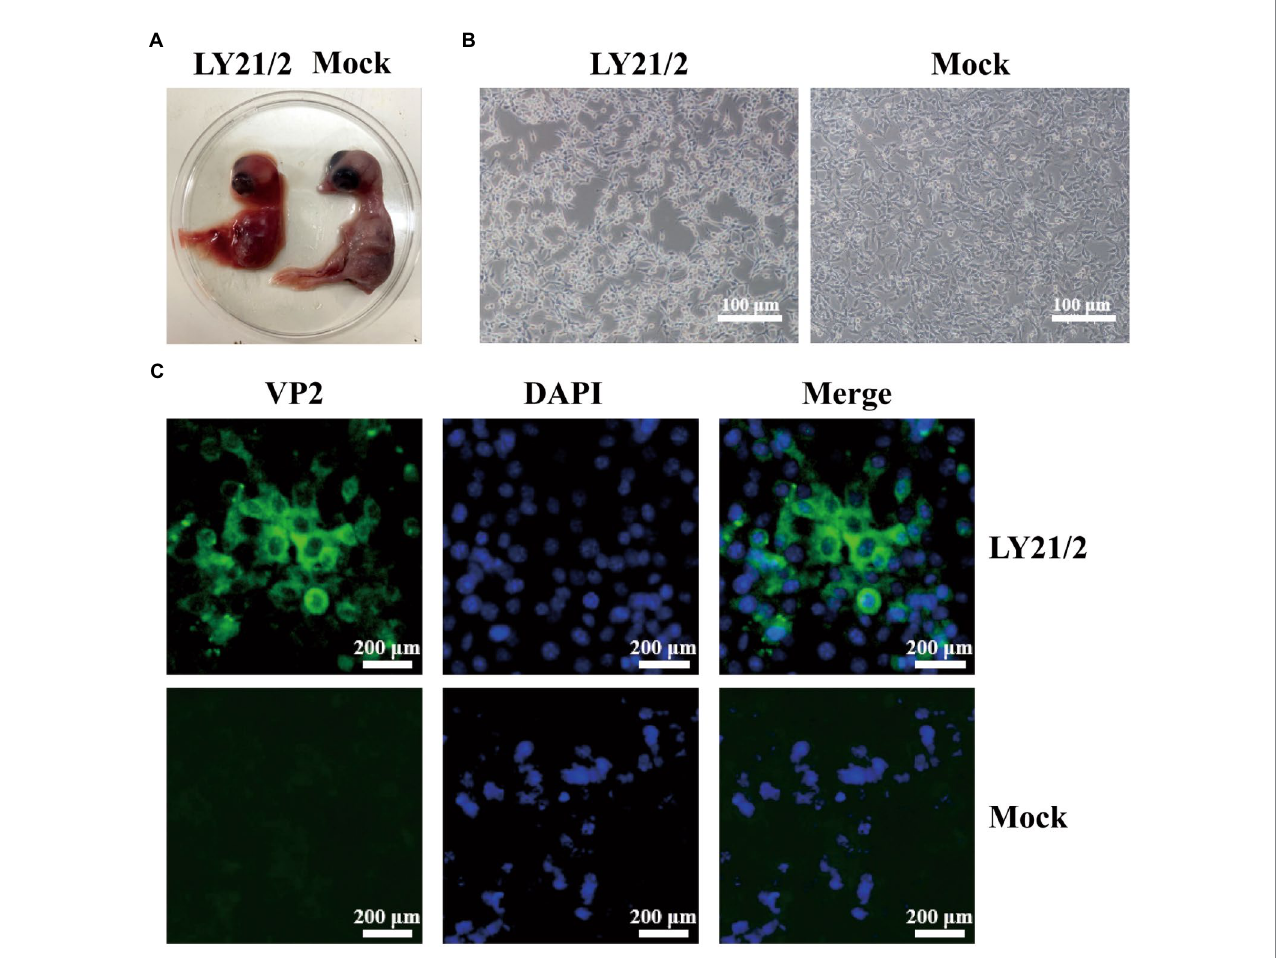
FIGURE 1 Isolation and identification of the variant IBDV strain LY21/2. (A) Isolation of the strain LY21/2 in 9-day-old chick embryo. Dwarfed carcass with congestion and haemorrhage was showed in dead embryo infected with LY21/2. (B) Isolation of the strain LY21/2 in cultured MC38 cells. The cells undergone shrinkage and aggregation at 24 h post infected with LY21/2. Scale bar, 100 μ m. (C) Immunological identification of the strain LY21/2 VP2 proteins expressing in MC38 cells. MC38 cells with LY21/2 infection were fixed and incubated with the mouse anti-VP2 monoclonal antibody followed by an Alexa Fluor 488-conjugated goat anti-mouse IgG secondary antibody. MC38 cells expressing VP2 proteins (green) and nuclear staining (blue) with DAPI were merged. Scale bar, 200 μ